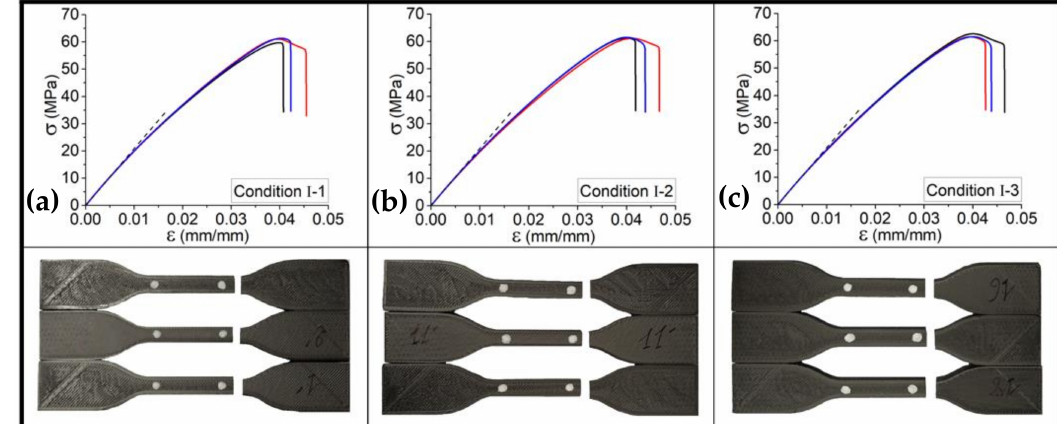
Figure 4. Tensile behavior for the set of printed samples according to conditions ( a ) I-1, ( b ) I-2, and ( c ) I-3, representing the variation of platform temperature. (The dash-lines show how the slope of the tensile curve